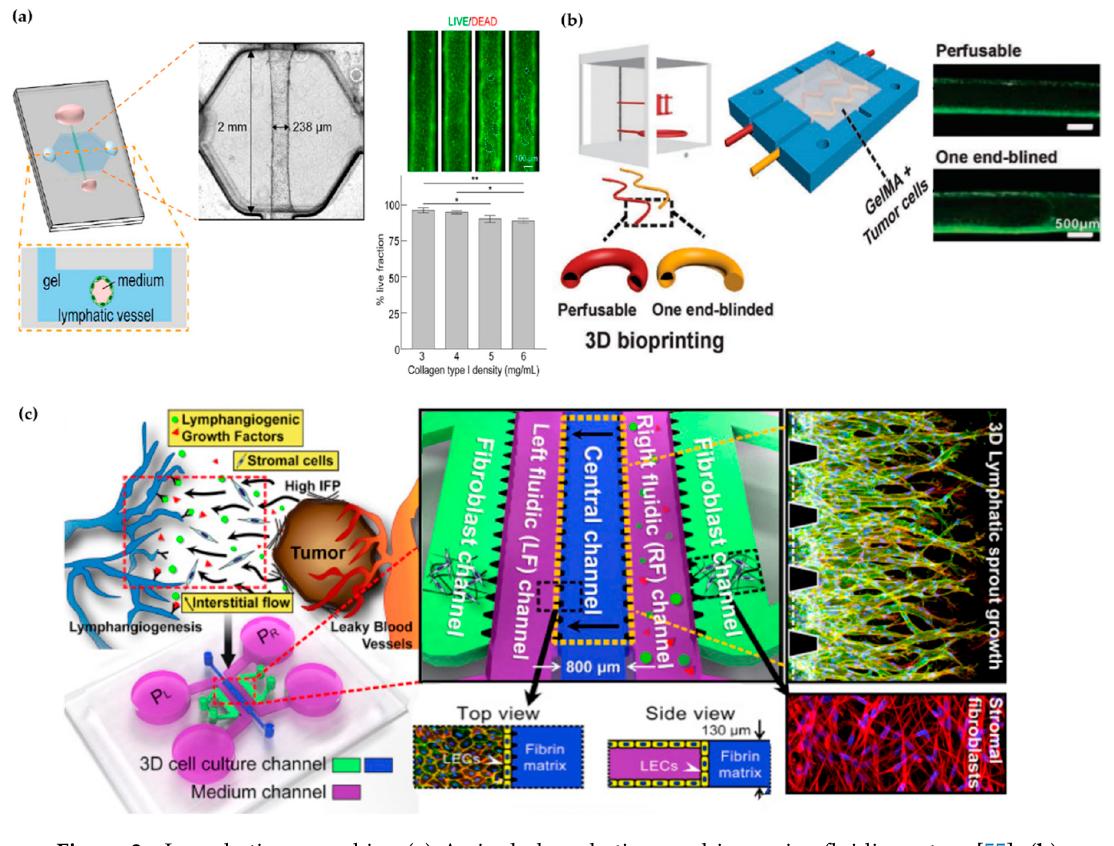
Figure 3. Lymphatics-on-a-chip: ( a ) A single lymphatic vessel in a microfluidic system [55], ( b ) bioprinted perfusable blood vessel and one-end-blinded lymphatic vessel on a microfluidic chip [56], ( c ) Generation of interstitial flow using pressure gradient created by the volume di ff erence between